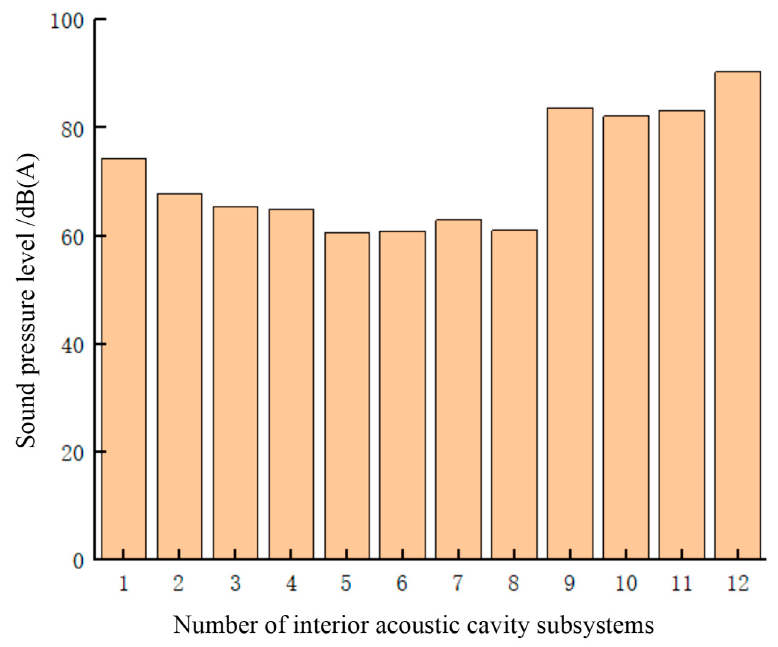
Figure 12. Sound pressure level of interior aerodynamic